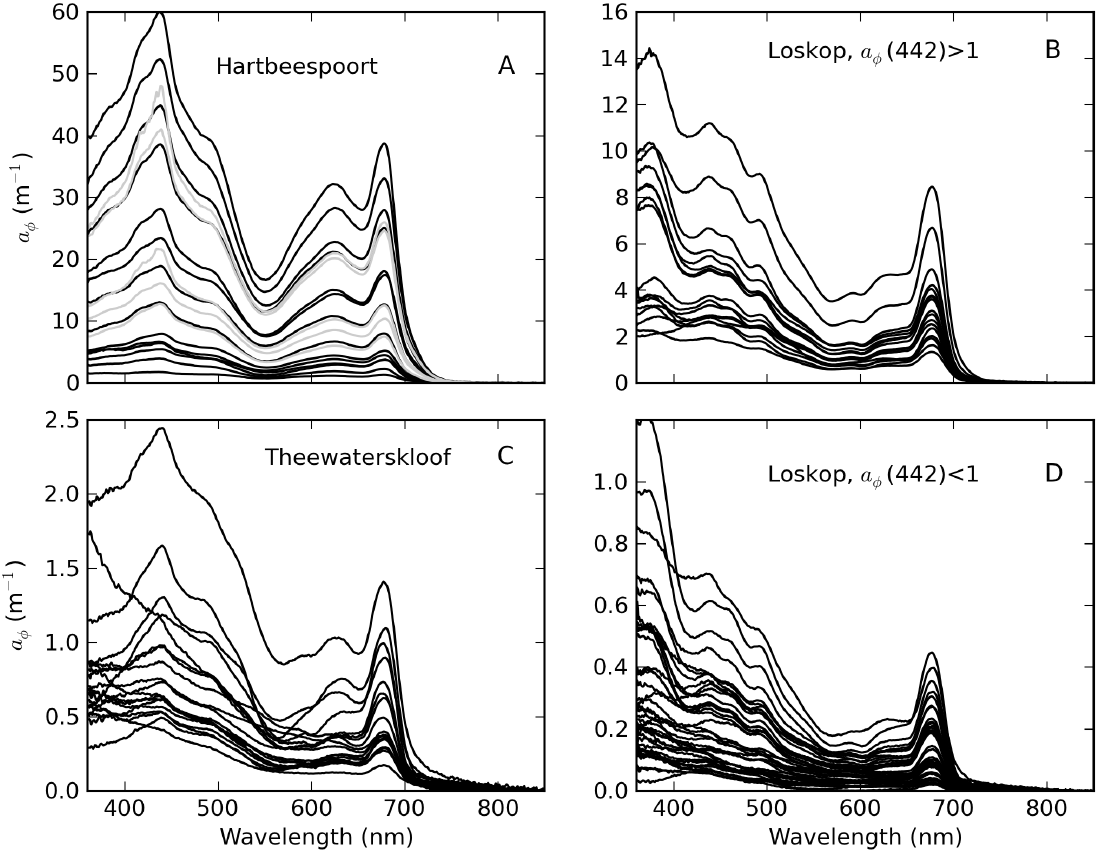
Figure 13. Spectral a a (442) > 1 ; ( C ) Theewaterskloof; and ( D ) Loskop for a p